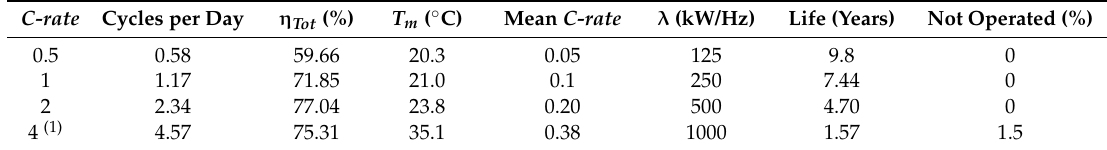
Table 8. PFC results for s = 0.4%, T 0 = 20 °C.